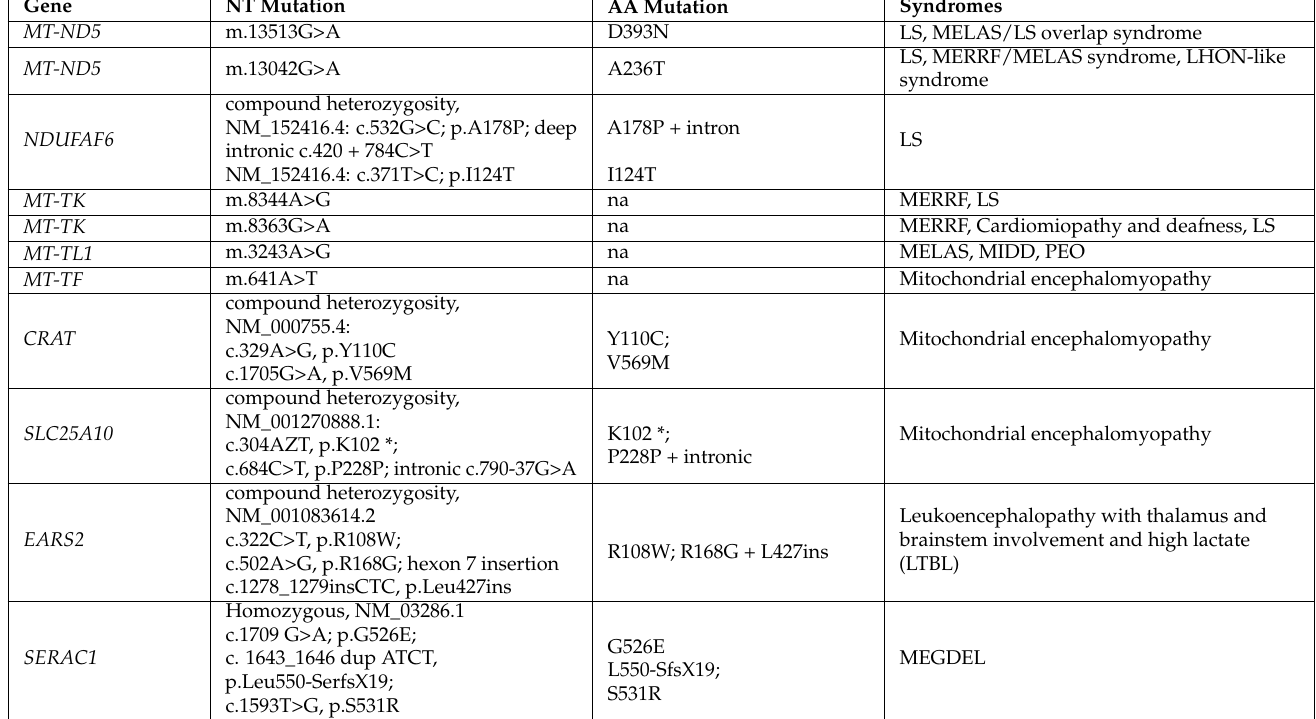
Table 5. Gene variants analyzed in our laboratories associated with the reported syndromes. Mutation nucleotide-numbering is based on reference sequences (RefSeq) for nuclear genes and on the genomic Revised Cambridge Reference Sequence (rCRS) sequence (RefSeq accession number NC_012920.1) for mitochondrial genes. “*” indicates a premature protein